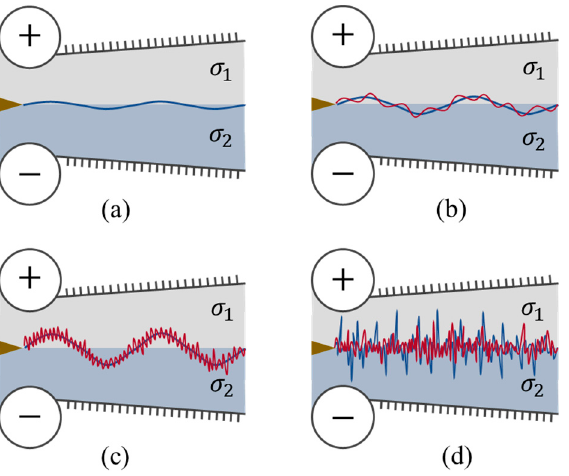
Figure 1. Schematic model of the evolution of EK flow with increasing electric fields.